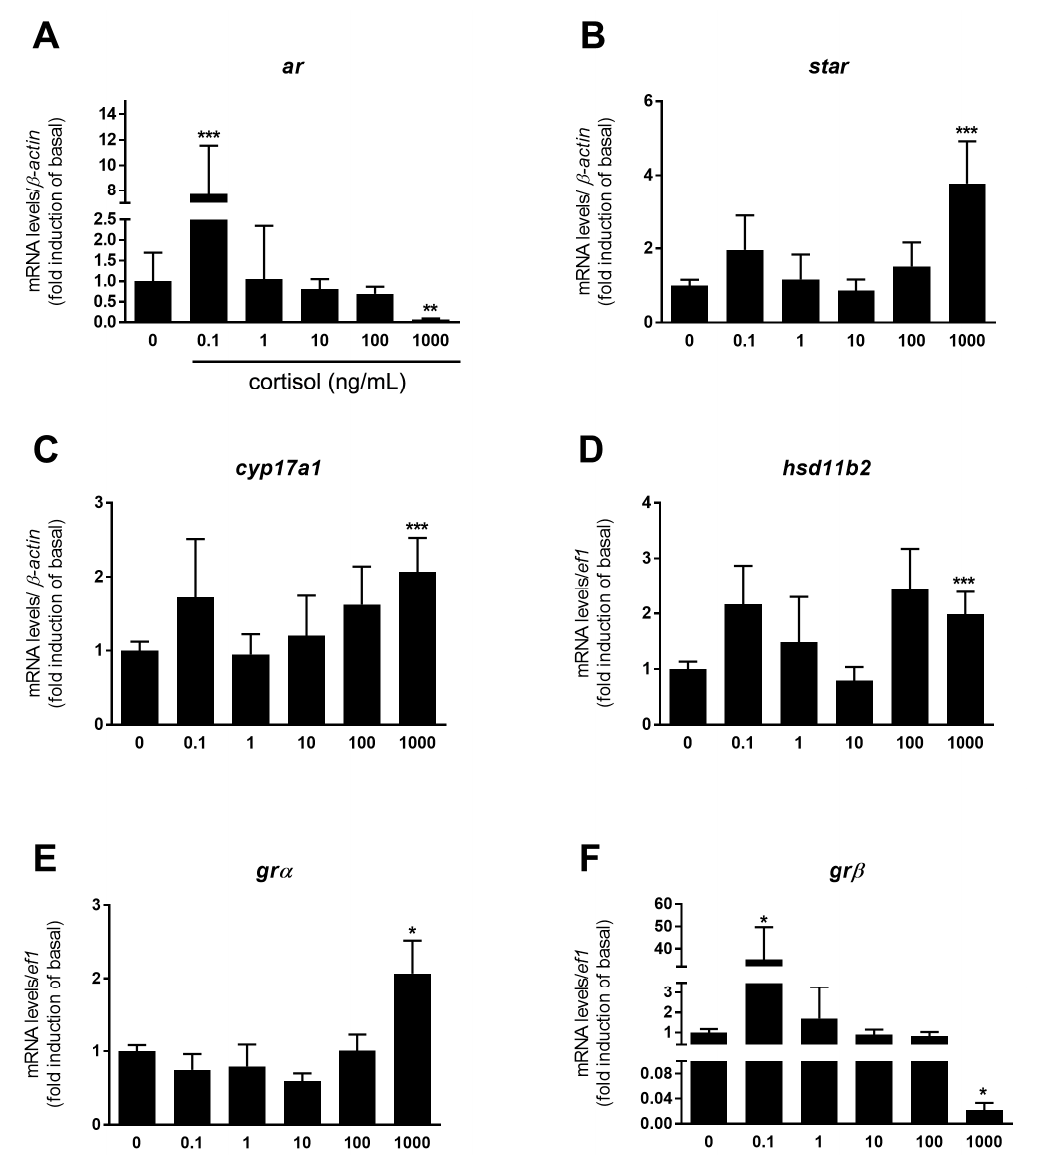
Figure 2. Relative mRNA levels of several selected genes in zebrafish testes incubated for 18 h (short-term exposure) to increasing concentrations of cortisol (0, 0.1, 1, 10, 100, and 1000 ng / mL). The selected target genes ar (androgen receptor) ( A ), star (steroidogenic acute regulatory) ( B ), cyp17a1 (17 α -hydroxylase / 17,20 lyase / 17,20 desmolase) ( C ), hsd11b2 (11-beta hydroxysteroid dehydrogenase) ( D ), gr α (glucocorticoid receptor alpha) ( E ), and gr β (glucocorticoid receptor beta) ( F ) were evaluated. Ct values were normalized with β -actin A–C ( ar , star , cyp17a1 ) and ef1 (elongation factor 1 α ) D–F ( hsd11b2 , gr α , and gr β ) and expressed as relative values of basal (0 ng / mL) levels of expression. Bars represent the mean ± SEM fold change ( n = 8), relative to the control (basal, 0 ng / mL), which is set at 1. Paired t -test, *** p < 0.001; ** p < 0.01; * p <